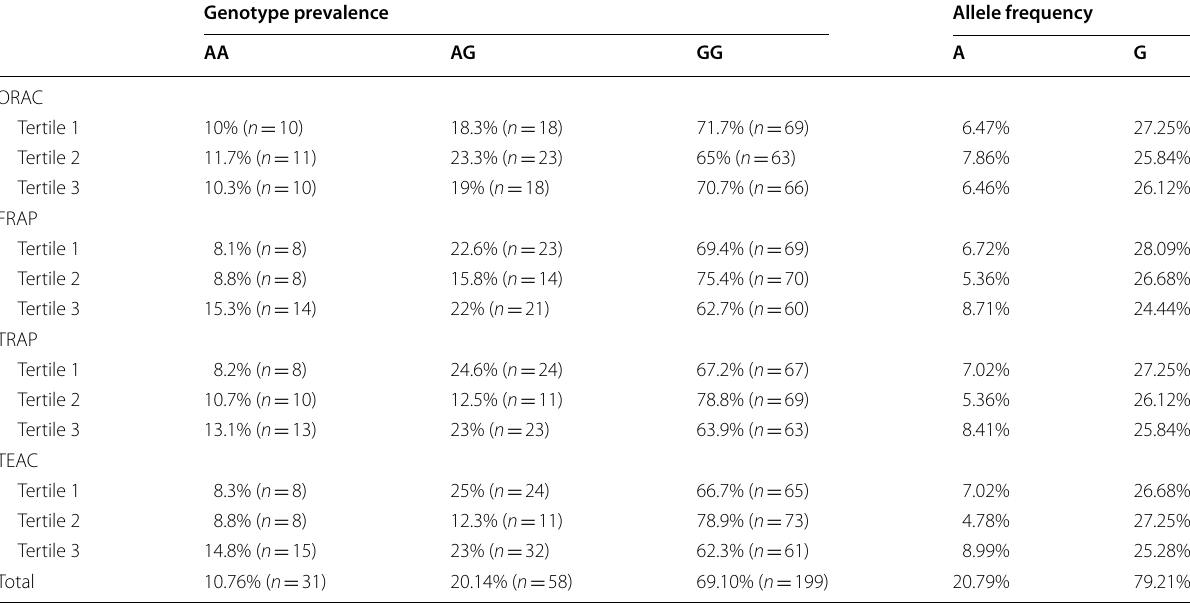
ORAC oxygen radical absorbance capacity, FRAP ferric reducing antioxidant power, TRAP total radical-trapping antioxidant parameter, TEAC Trolox equivalent antioxidant capacity